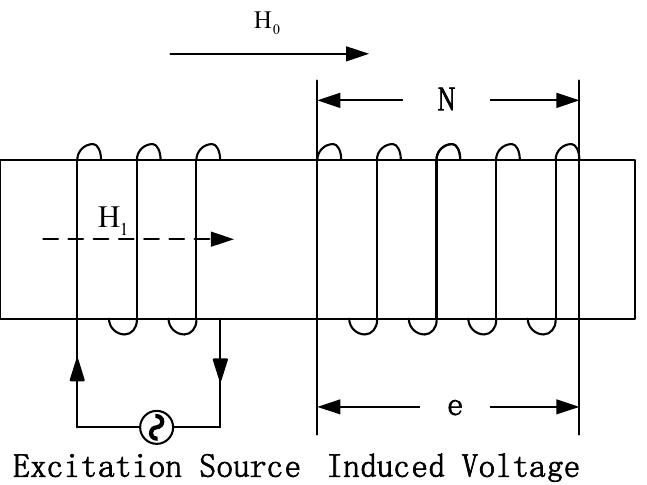
Figure 2. Single-core fluxgate sensor structure.